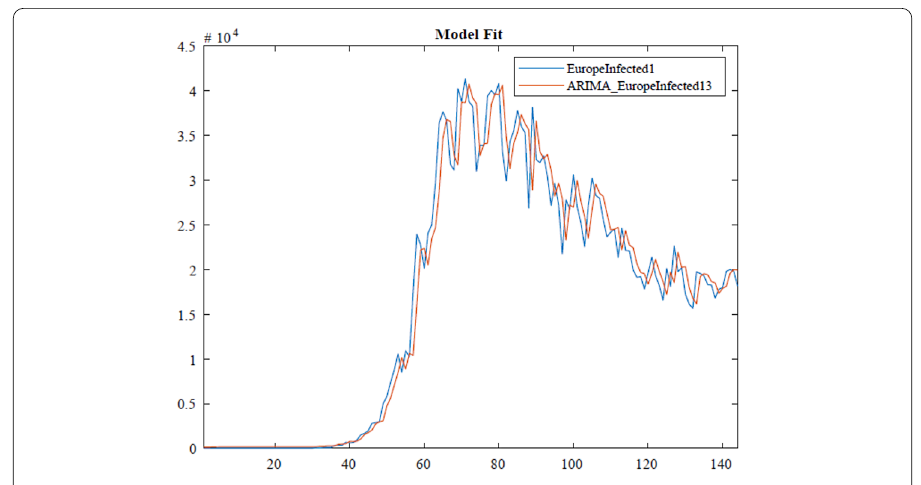
Figure 5 ARIMA model for the infected in Europe